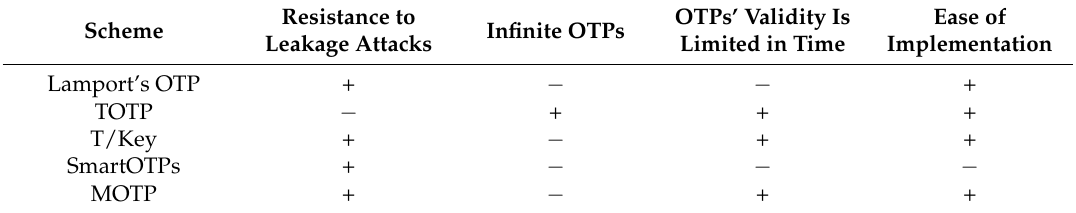
Table 6. Scheme comparison. TOTP, Time-based One-Time